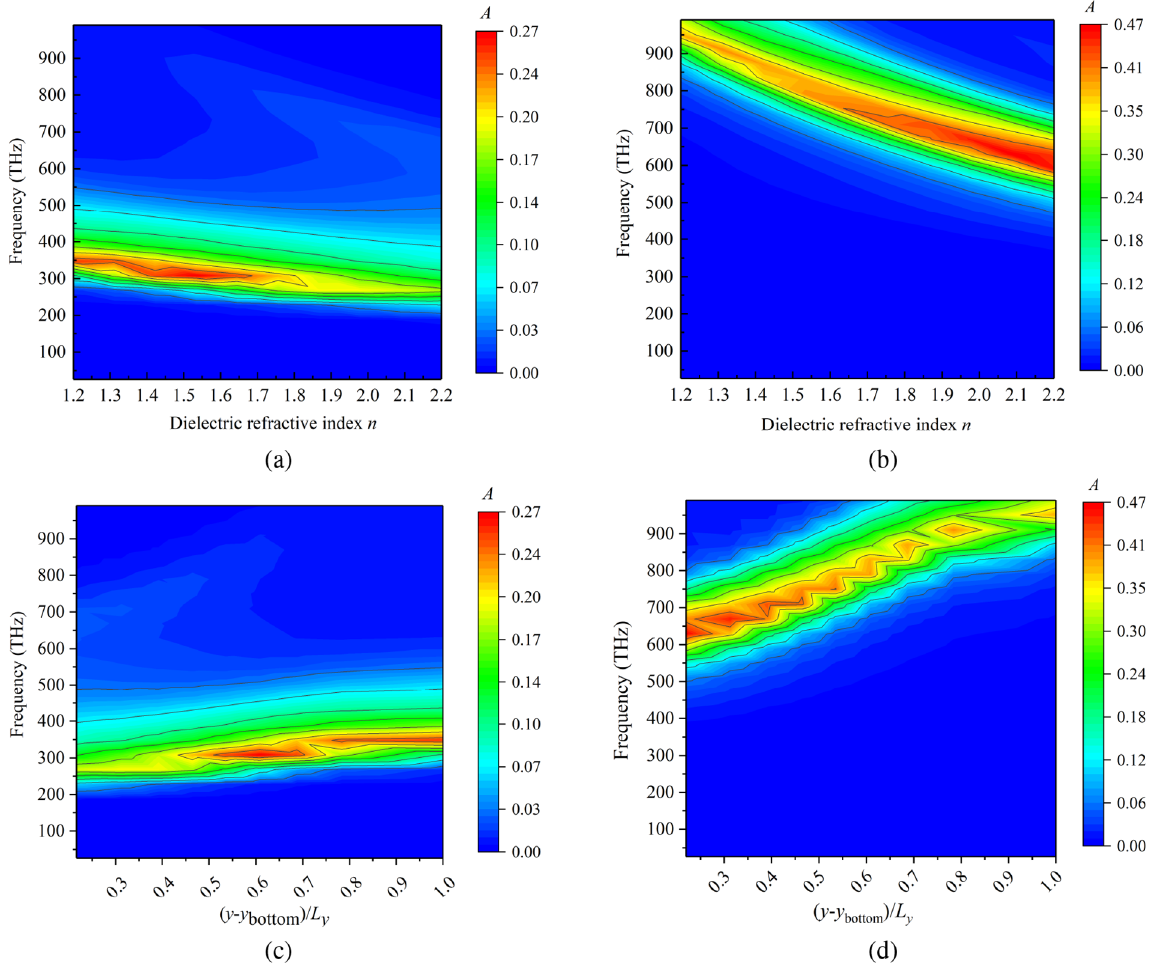
Fig. 7. 2D color contour plots of absorptance (similar to those in Fig. 5, but in the cases where the single metallic rod consists of: TiN (cases (a) and (c)) with radius of 24 nm, and W (cases (b) and (d)) with radius of